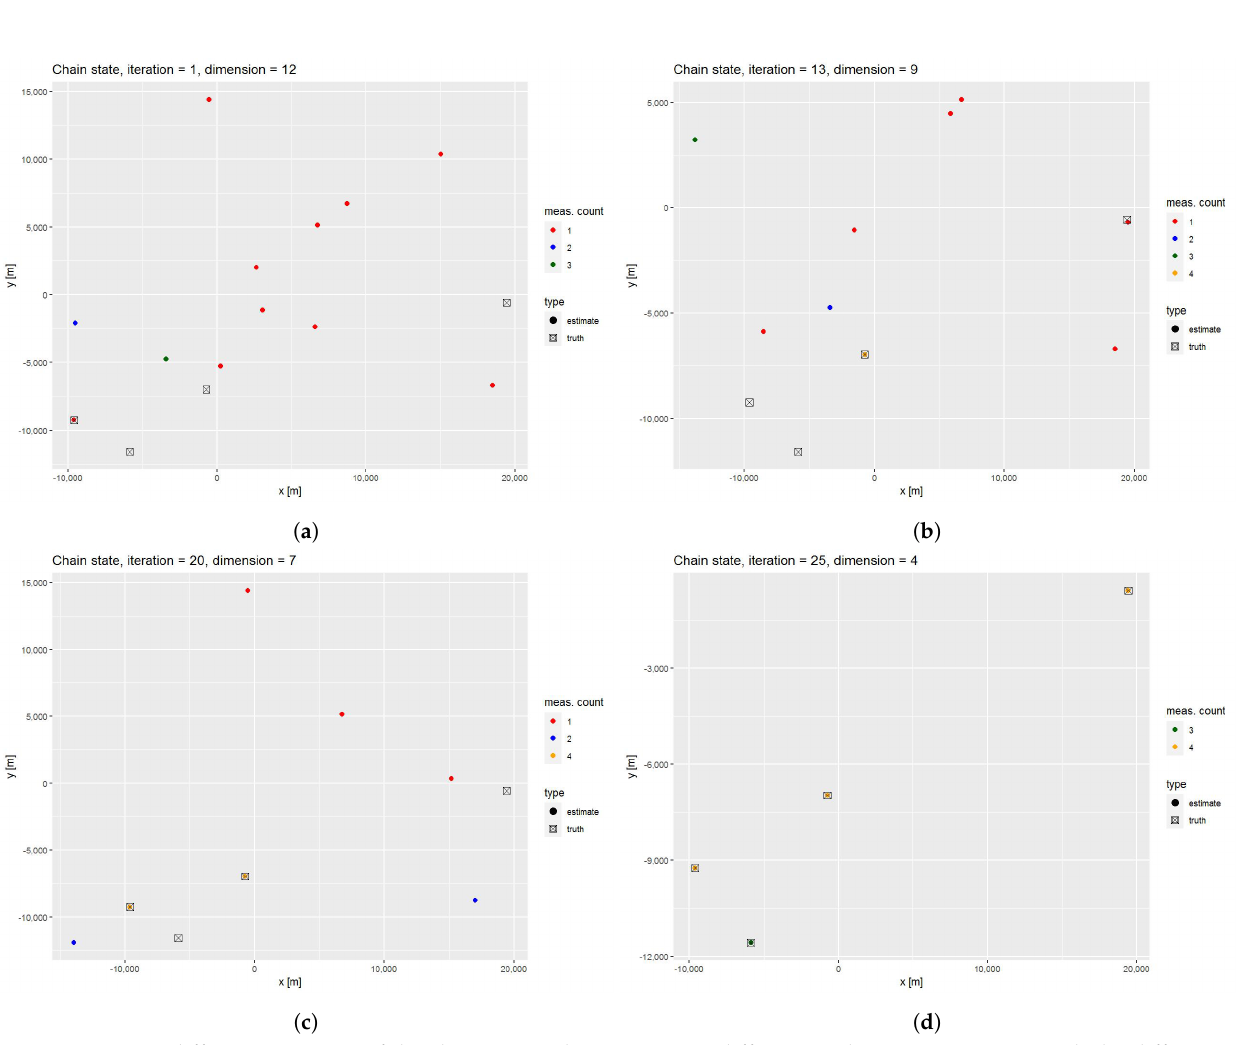
Figure 4. Four different iterations of the chain. At each iteration, we differentiate between estimates with the different number of bistatic measurements (red for one bistatic measurement, blue for two, green for three and yellow for four bistatic measurements). Dot marks are used for estimated positions and boxes for the true target positions: ( a ) chain state at the first iteration with 12 initiated targets, none of the four measurement targets and only one nearby the true target location; ( b ) chain state at the 13th iteration with 9 estimated targets, one of them consisting of four measurements; ( c ) chain state at the 20th iteration with 7 estimated targets, two of them consisting of four measurements, both of them nearby the true target’s location; and ( d ) chain state at the 25th iteration with 4 estimated targets, each corresponding to the true target’s